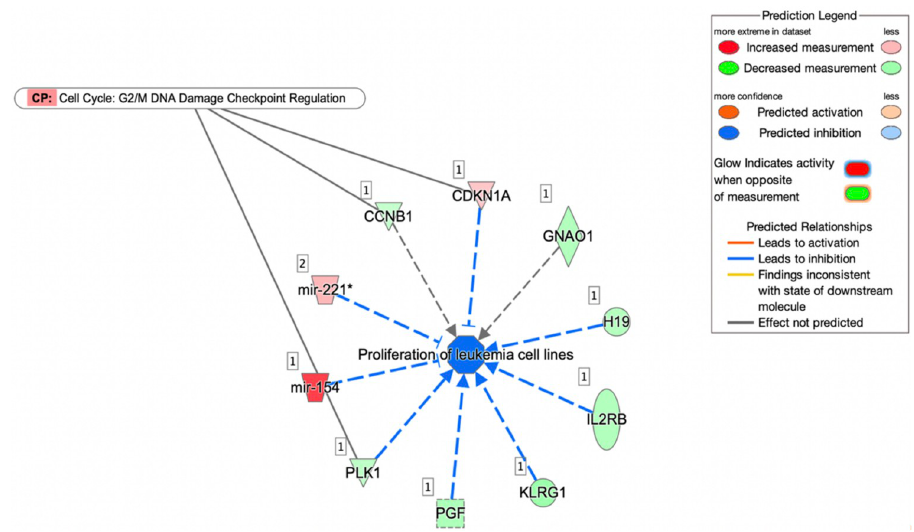
Fig 10. The top-scoring disease network (proliferation of leukaemia cell lines) for MOL-treated hWJMSCs.